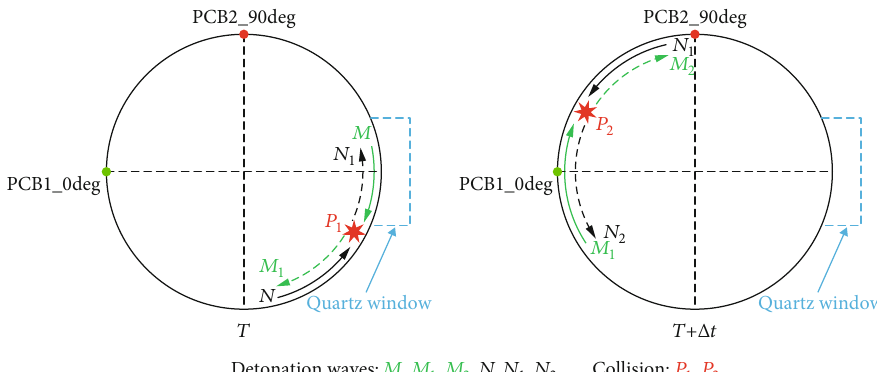
Figure 8: Schematic view of counter-rotating two-waves mode.